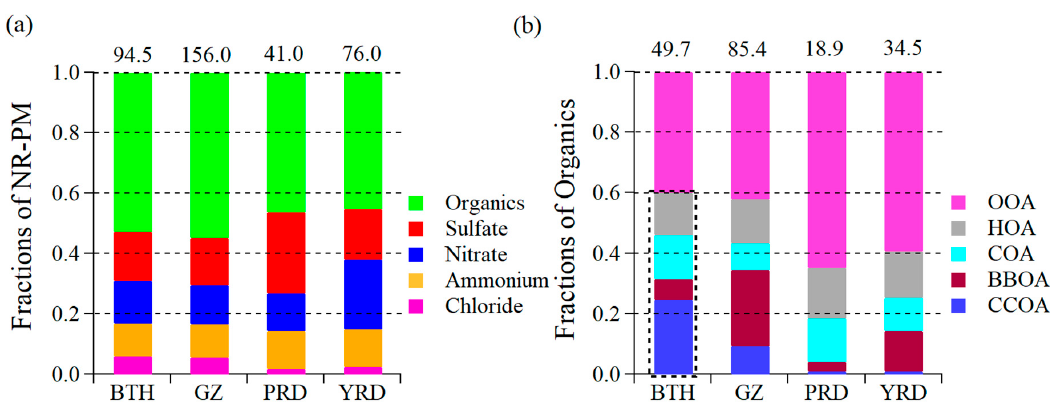
Figure 2. ( a ) Chemical compositions of non-refractory particulate matter (NR-PM) and ( b ) fractions of organic sources in the four representative regions of China during wintertime. The dotted box refers to the primary organic aerosols. The numbers above the bars represent the average mass concentrations of ( a ) total NR-PM and ( b ) organic aerosols across the four regions. BTH: Beijing-Tianjin-Hebei